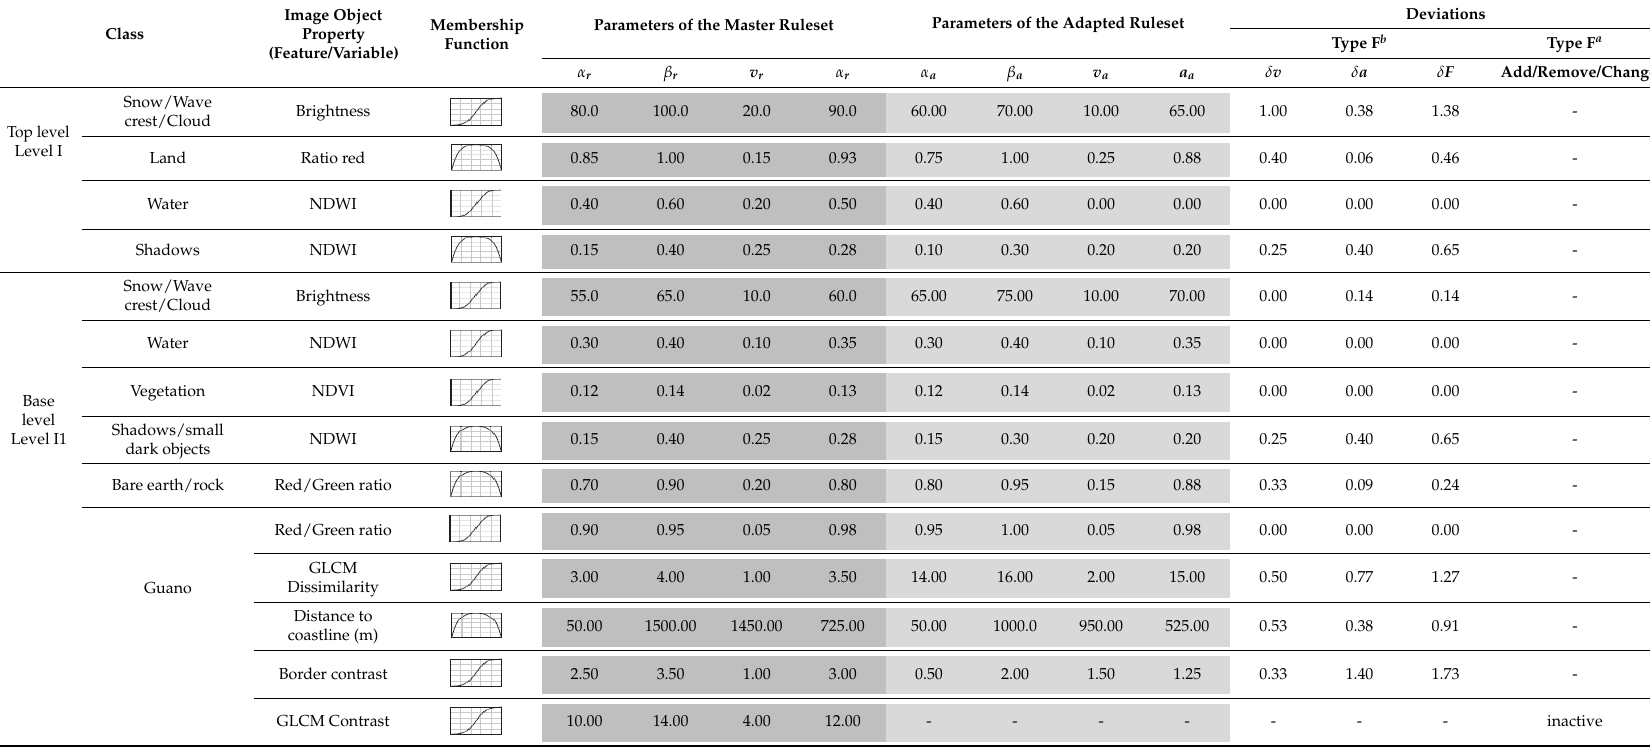
function describing property p : α —lower border, β —upper border, v —range, a —mean. Subscripts r and a denote reference ruleset and adapted ruleset,